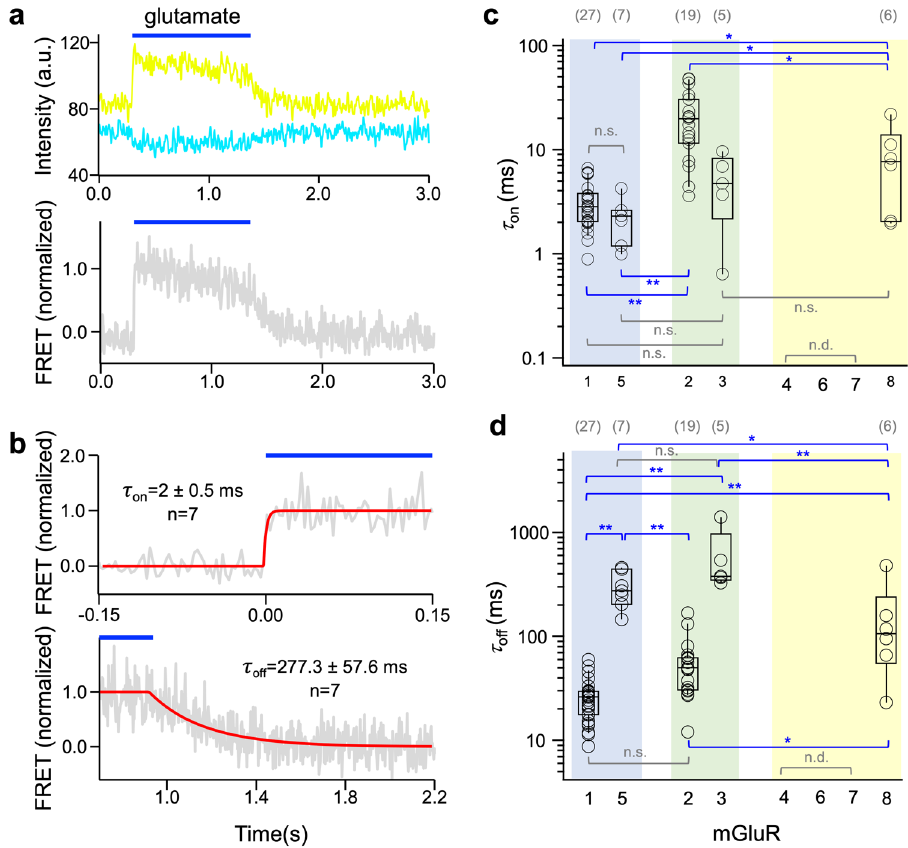
Fig. 3 Activation and deactivation kinetics in homodimeric mGluRs. a Time course of fl uorescence changes for donor and acceptor in dimeric mGluR5 (top) and resulting FRET signal (bottom). Here and in the following, the blue bar indicates the application of 1 mM glutamate. Shown are representative photobleaching and cross-talk corrected traces of CFP (cyan) and YFP (yellow) as well as the corrected normalized FRET signal (gray). b Time courses of activation (top, τ on ) and deactivation (bottom, τ off ) of an individual experiment (gray). The superimposed curves are best fi ts to average traces obtained from n = 7 individual traces each. c , d Activation ( c ) and deactivation ( d ) time constants for the mGluRs. Three mGluRs did not show evaluable time courses. n.d., not determinable. Signi fi cant differences are indicated (ANOVA followed by Turkey-Kramer posthoc test, see Methods: * p < 0.05, ** p < 0.01). In c and d the numbers of experiments are shown at the top in